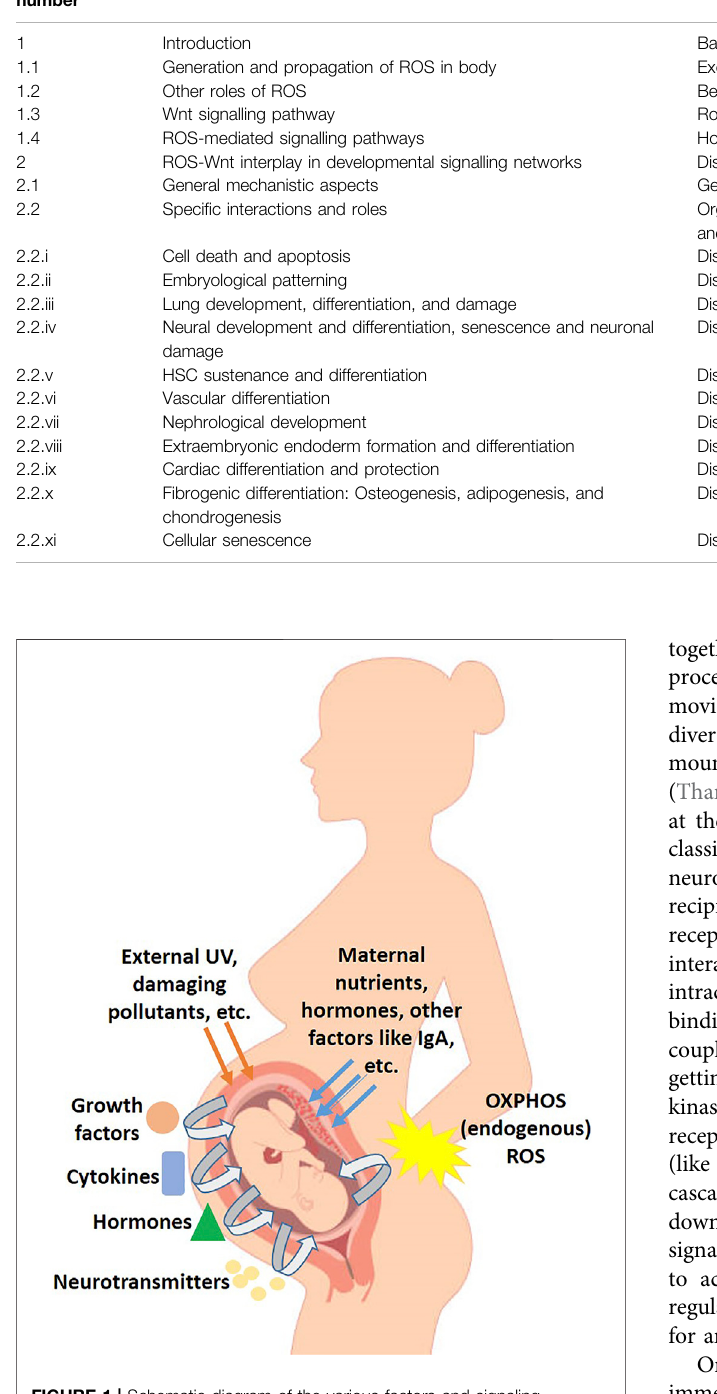
Frontiers in Molecular Biosciences |